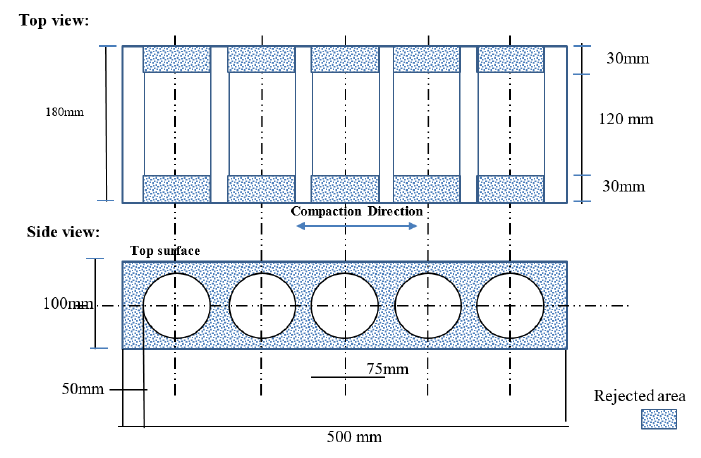
Figure 5. Coring graphical illustration.